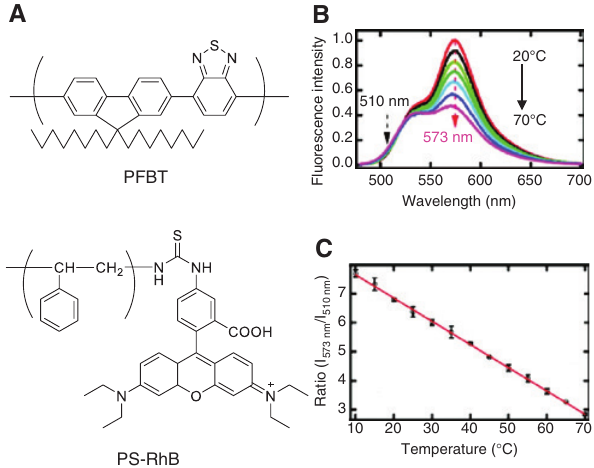
Figure 12: Ratiometric temperature sensing using a combination of PFBT and PS-RhB.